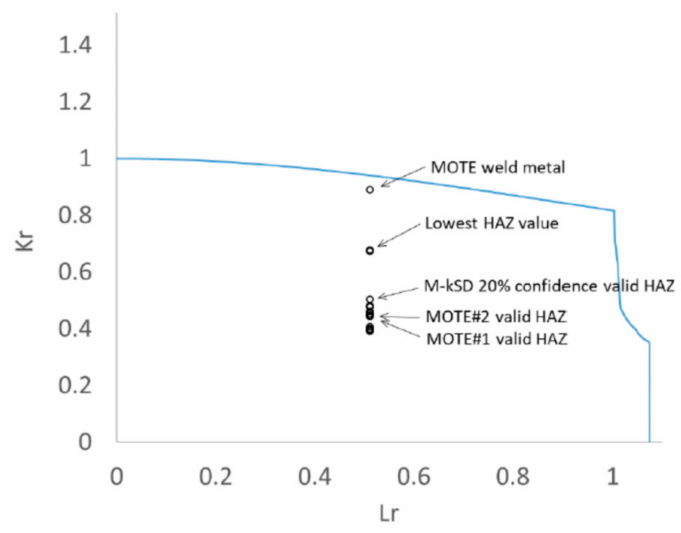
Figure 15. Failure Assessment Diagram (FAD) showing example pipe girth weld assessments with sensitivity cases for a range of fracture toughness values based on interpretation of these experimental results listed in Table